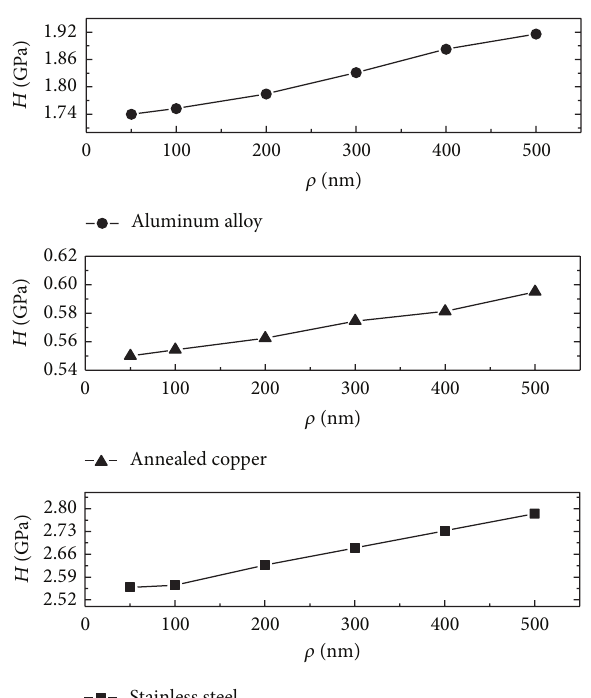
Figure 4: The hardness estimated by imperfect